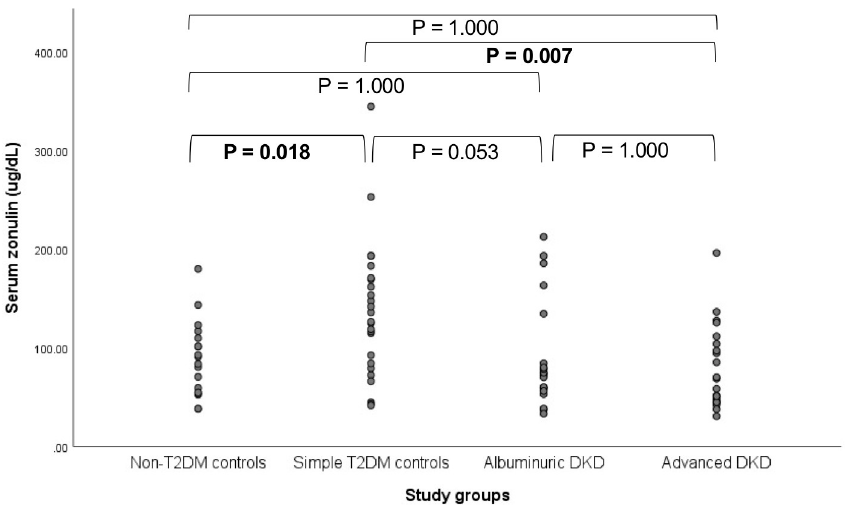
Fig 1. Serum zonulin levels among groups. Serum zonulin levels are expressed in median among different study groups. Values in bold indicate p < 0.05. T2DM: Type 2 diabetes mellitus; DKD: Diabetic kidney disease. https://doi.org/10.1371/journal.pone.0253501.g001 After 5 years, 66 patients (76.7% of the sample) were evaluated for renal and cardiovascular outcomes and death. With respect to renal outcomes, 24 patients had renal function decline (39.3%), 10 patients started dialysis (15.5%) and just one patient had renal transplantation (1.5%). Regarding cardiovascular outcomes, 6 patients had heart attack (9.2%), 3 patients had